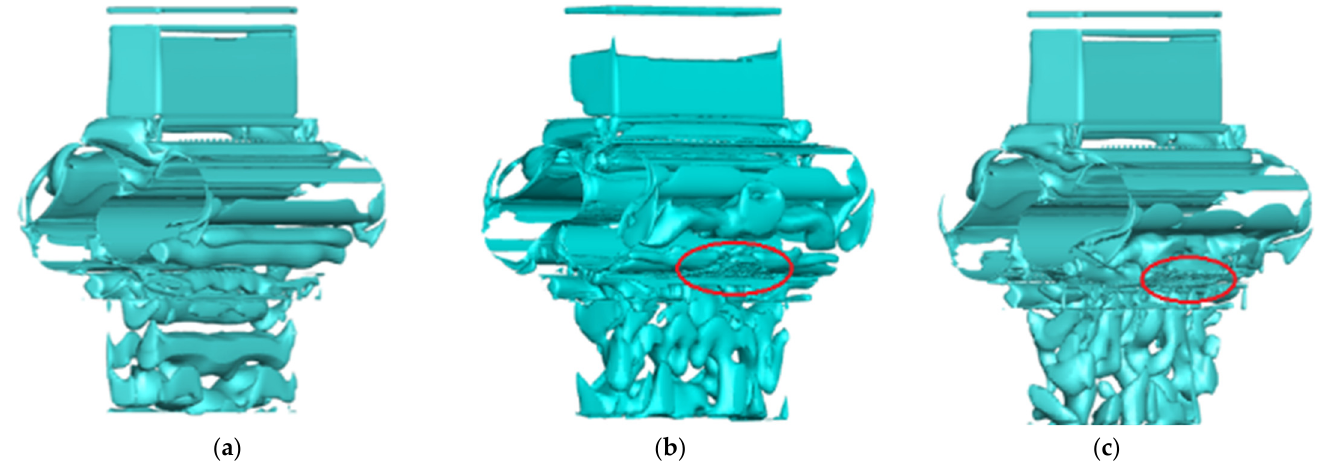
Figure 15. Internal vortex structure of the Roots pump before and after optimization: ( a ) original model; ( b ) Model 14; ( c ) Model 5.